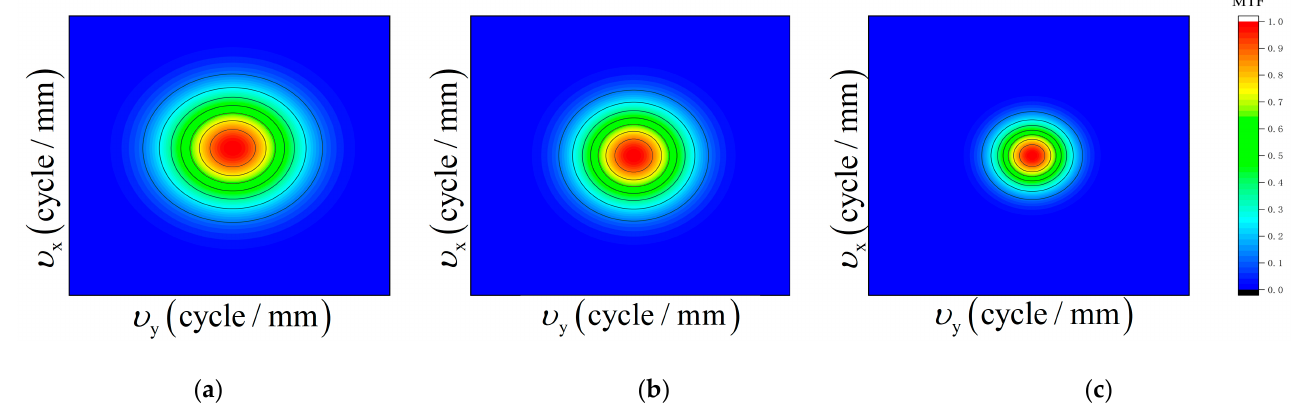
Figure 10. Image filter template: ( a ) attitude angle 0°; ( b ) attitude angle 30°/ − 30°; and ( c ) attitude angle 50°/ − 50°.